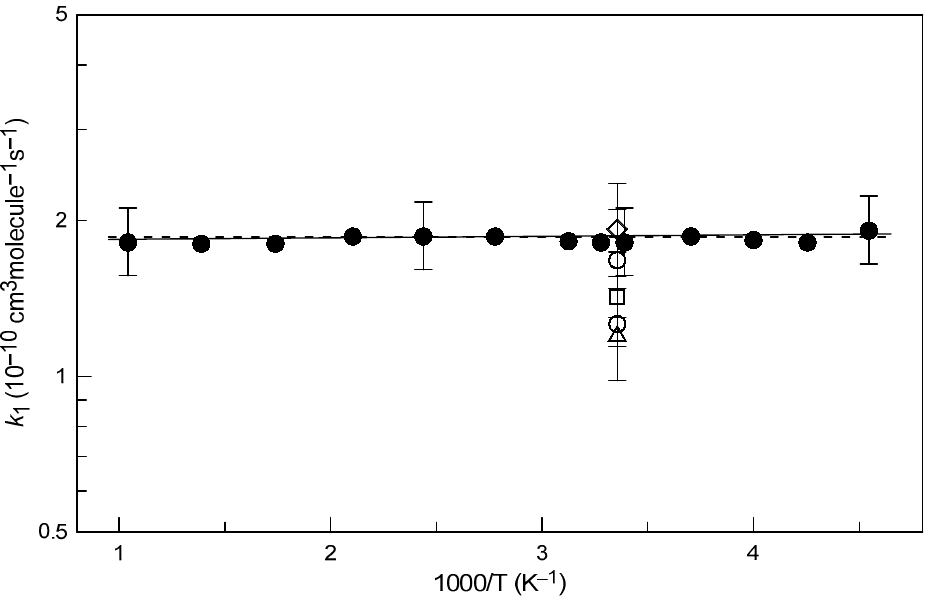
Figure 4. Summary of the measurements of k 1 : diamonds, Williams and Rowland [9]; triangles, Smith et al. [10]; open circles, Schölne et al. [12]; squares, Persky [11]; filled circles, this work. Uncertainties shown for selected present measurements of k 1 correspond to 15%.